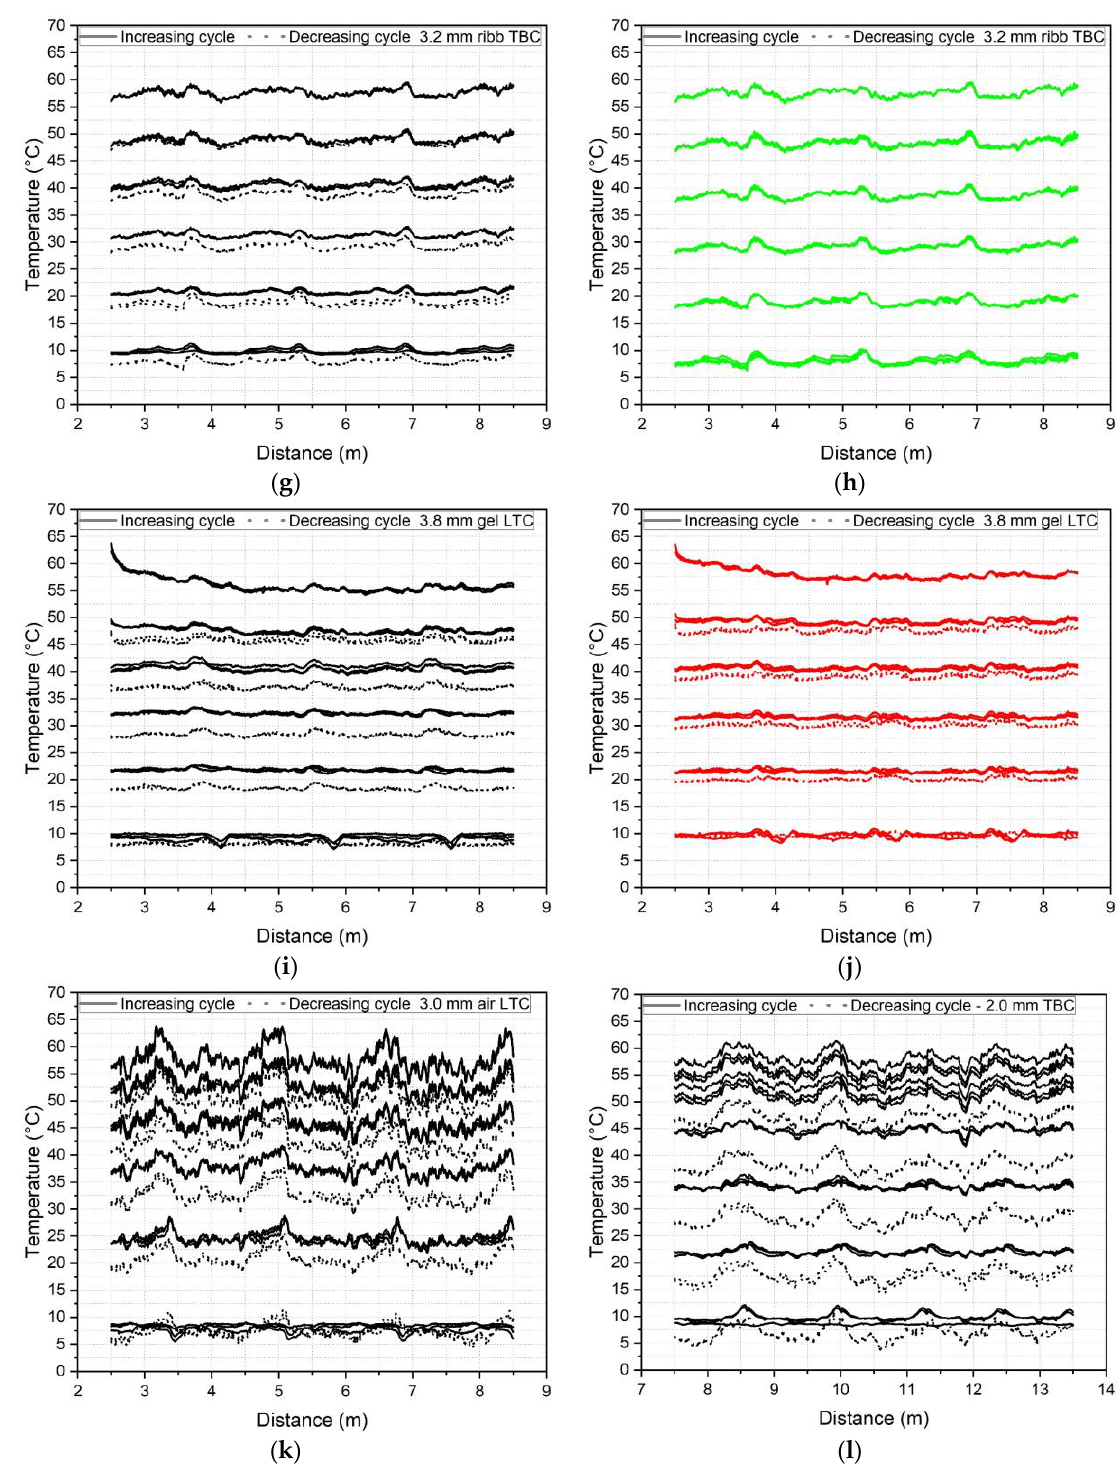
Figure A3. Length stability along analysed cable section for temperature steps of 10 – 60 – 10 °C for